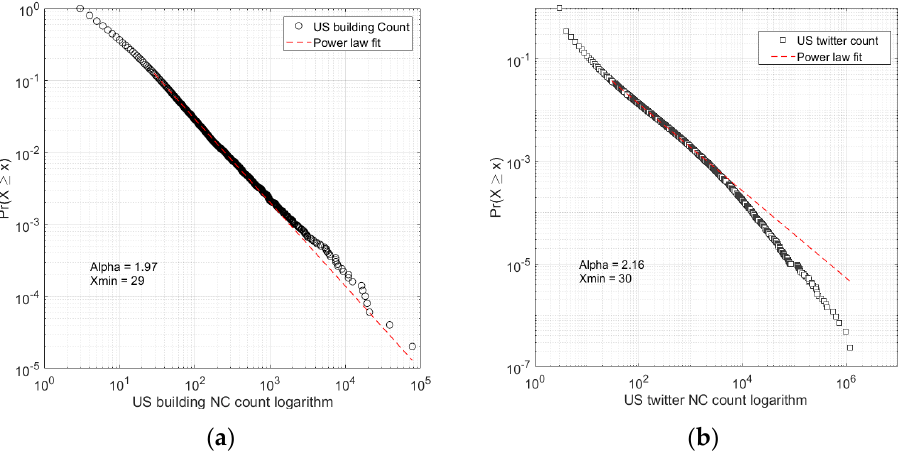
Figure 3. The power law fit of US building and US Twitter natural cities. ( a ) US building NC count logarithm ( b ) US twitter NC count logarithm.